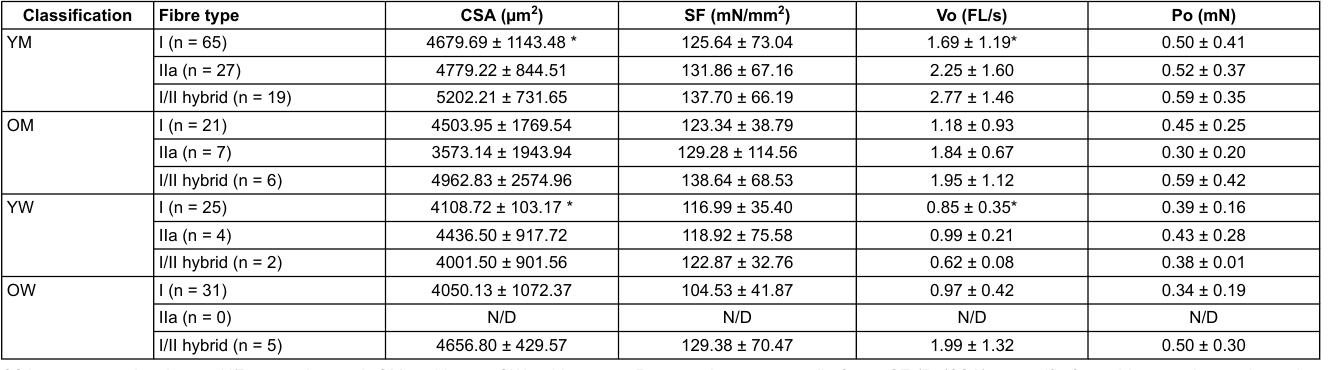
Table3: Characteristics of human vastus lateralis single muscle fibres.